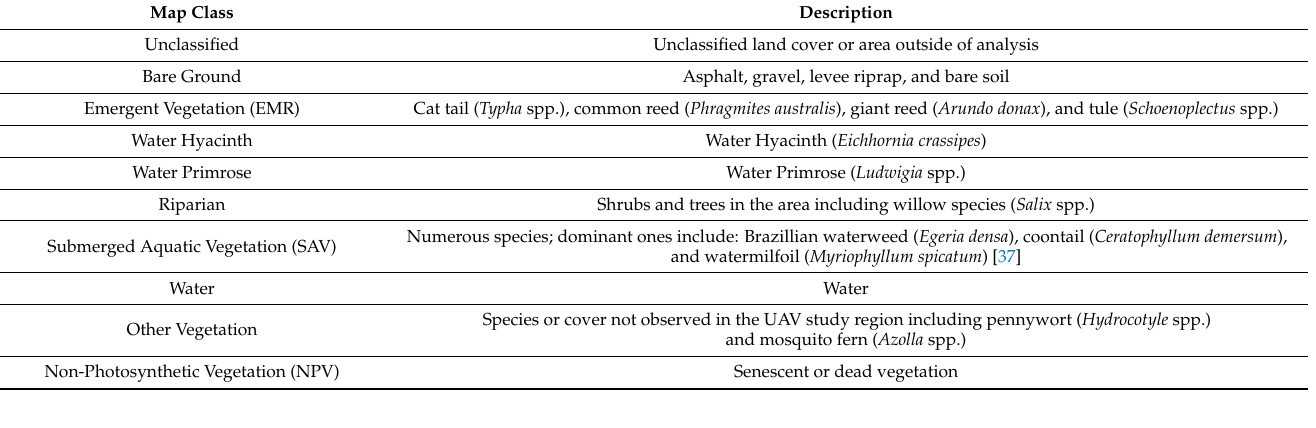
Table 1. Classes of interests and descriptions for the unmanned aerial vehicle (UAV) and manned flights.